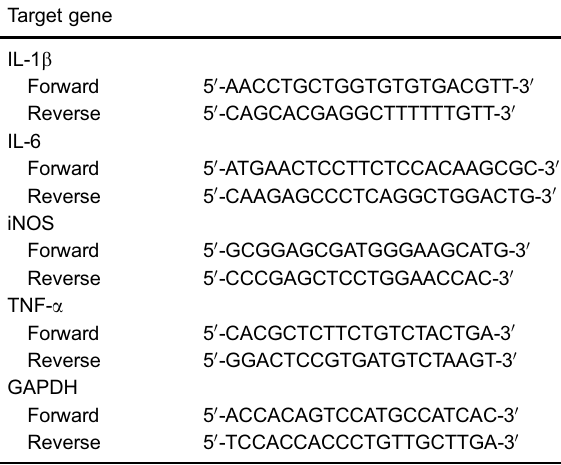
Table 1. List of primer